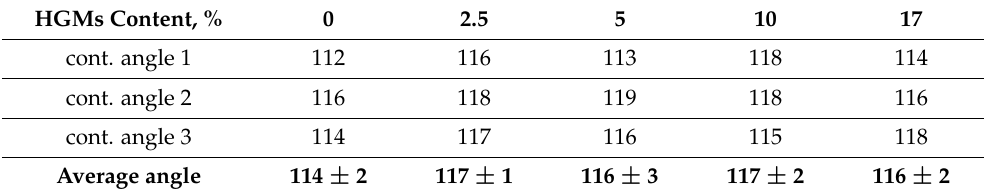
Table 1. Results of the water droplet contact angle measurements.